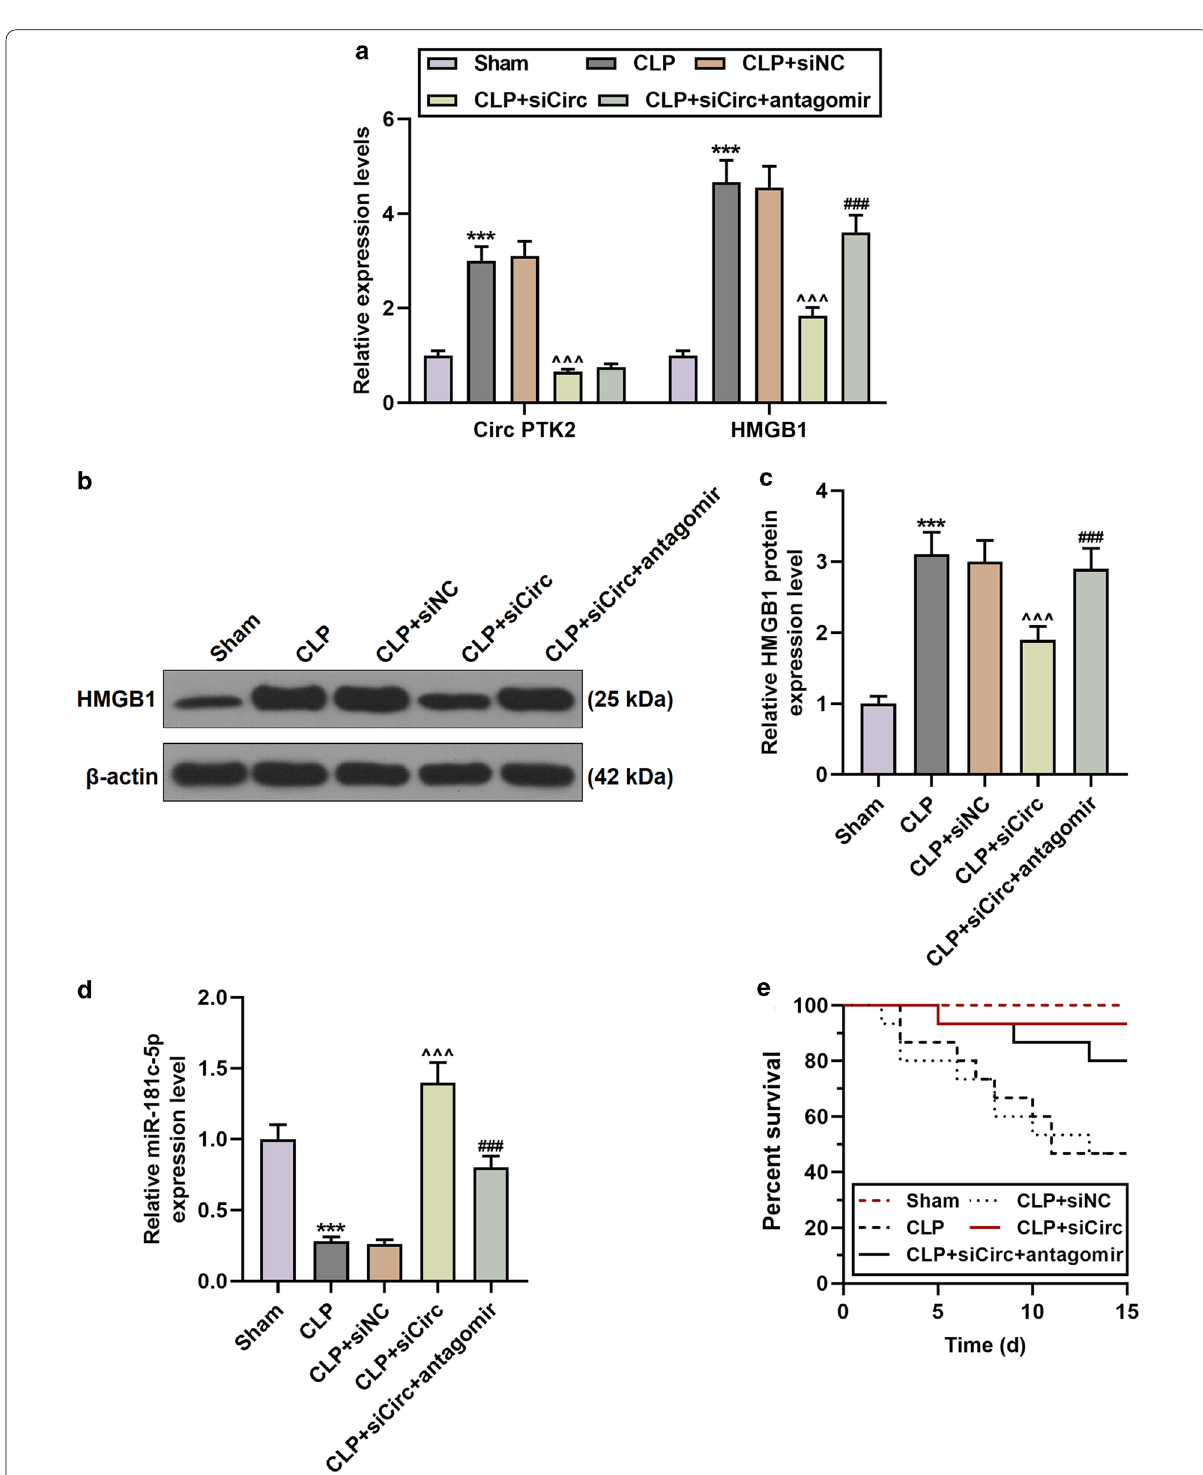
Fig. 8 The relationship between circPTK2, miR-181c-5p and HMGB1 in CLP-induced mice. a – d The expressions of circPTK2, miR-181c-5p and HMGB1 in the hippocampus tissues of mice in the Sham, CLP, CLP and Western blot. N 3 for each column; *** P < 0.001 vs. Sham; ^^^ P < 0.001 vs. CLP = by Bonferroni’s post-hoc test. e Kaplan–Meier curve was used to calculate the survival rate of mice in each group. N Puncture; Sicirc sicircPTK2; qRT-PCR quantitative reverse transcription real time polymerase chain reaction. β-actin or U6 were used as